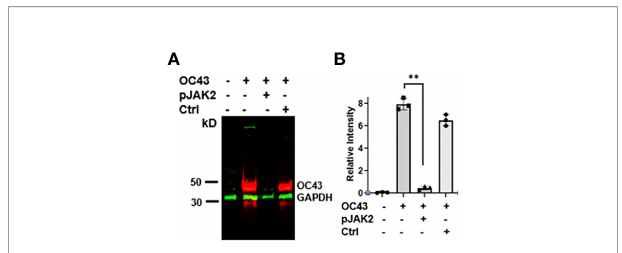
FIGURE 2 | (A) Expression of HuCoV-OC43 induced protein is downregulated by pJAK2 peptide. Proteins from cell extracts (equal amounts) of untreated, virus only or the cells infected with the virus in the presence of pJAK2 or control peptide were run on acrylamide gel, transferred to PVDF membrane and probed with primary antibodies to anti-mouse HuCoV-OC43 and anti-rabbit GAPDH (internal control). They were next probed with IR conjugated secondary anti-mouse antibody (red) and anti-rabbit antibody (green). The membrane was scanned in Odyssey IR imaging system (Licor Biosciences). The experiment was repeated using the same conditions two more times. From the three blots, relative intensities between the OC43 and GAPDH bands were calculated using image J and are shown in (B) **p < 0.001 between the infected cells and infected cells in the presence of pJAK2